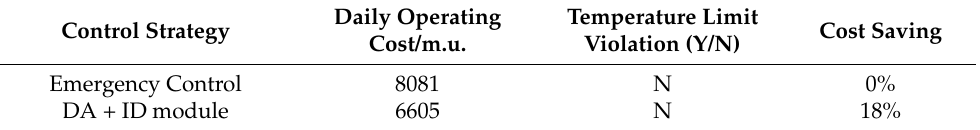
Table 5. Port operating cost